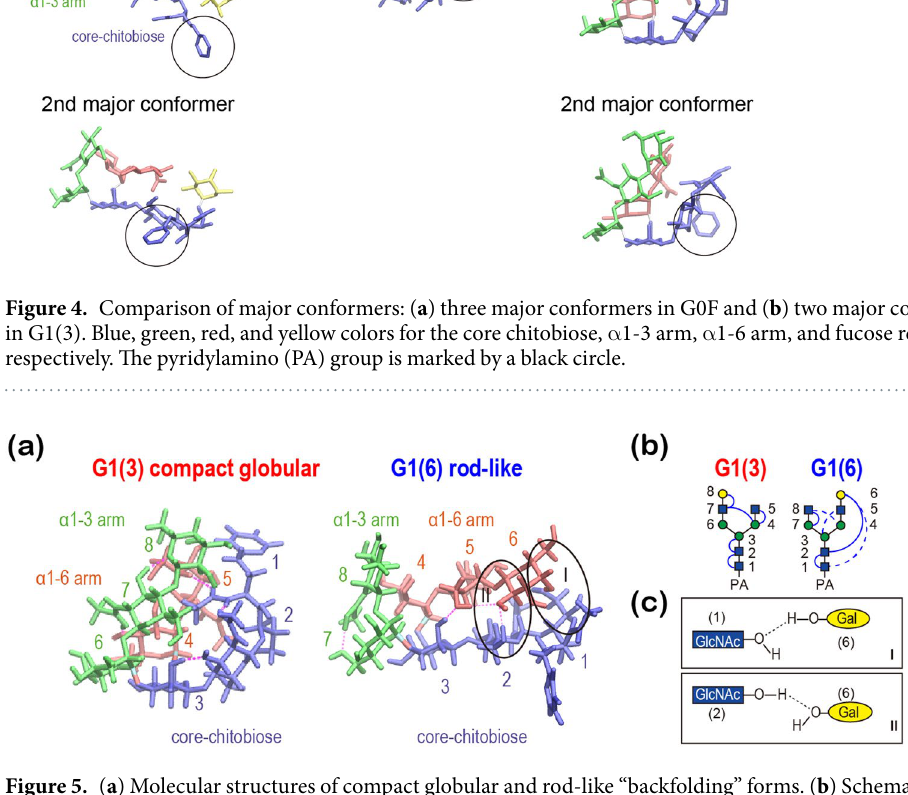
Figure 5. ( a ) Molecular structures of compact globular and rod-like “backfolding” forms. ( b ) Schematic illustration of H-bond networks (solid line for > 70% and dashed line for > 50% probability). The geometric definition was used to identify H-bonds: R XY < 3.5 Å and θ HXY < 30°, where R XY is the distance between heavy atoms X and Y, and θ HXY is the angle between X–H bond and X–Y vectors. ( c ) Key inter-arm H-bonds in “backfolding” structure (H-bond with the first GlcNAc residue (I) and H-bonds with the second GlcNAc residue